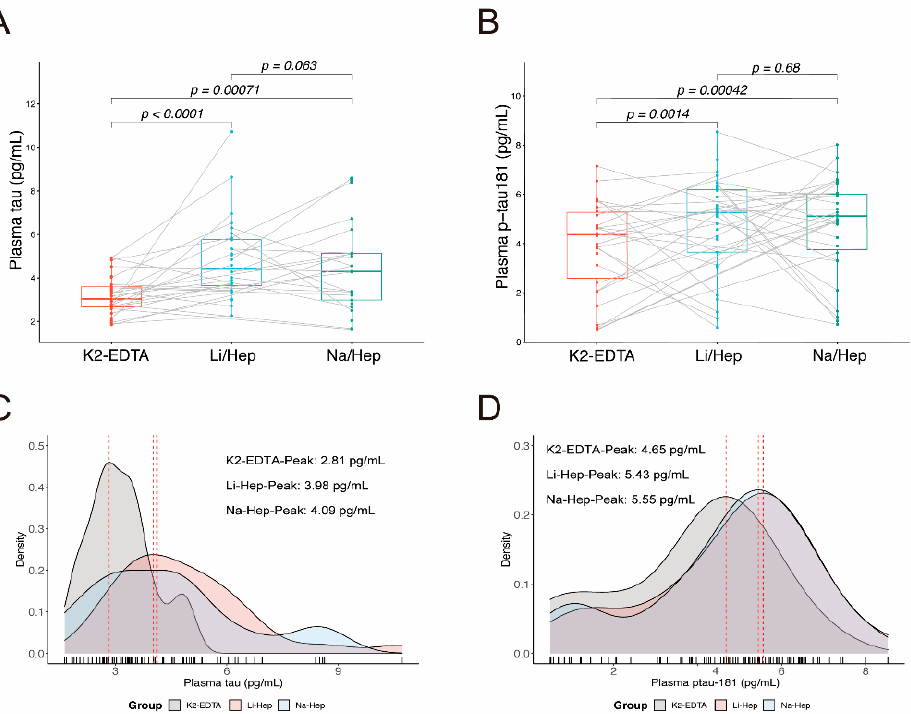
Figure 1. Blood collection methods affect the detection of tau and p-tau181 levels. ( A , B ) AD biomarkers comparison among K2-EDTA, Li-Hep, and Na-Hep tubes, including tau ( A ) and p-tau181 ( B ), Data were means ± SD; ( C , D ) Density plot of tau ( C ) and p-tau181 ( D ) among K2-EDTA, Li-Hep, and Na-Hep tubes. ( A , B ): The differences between groups were assessed by paired t-tests; ( C , D ): The peak levels were calculated and statistically compared using the Kolmogorov–Smirnov test. n was indicated in the methods and Table 1.